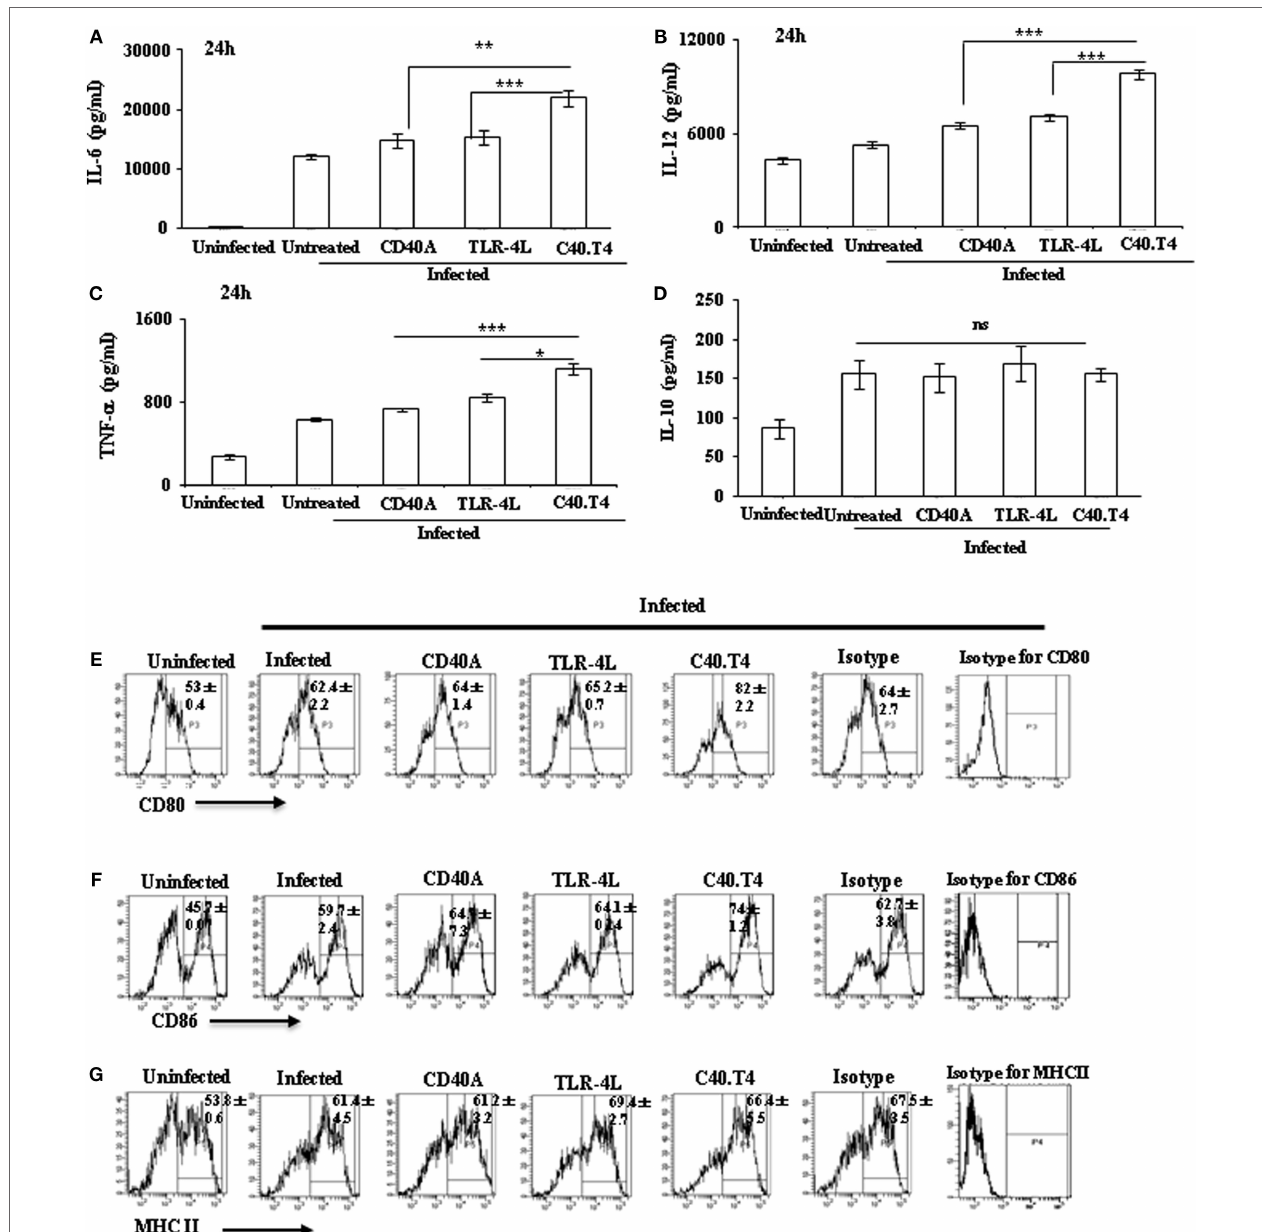
FigUre 1 | signaling through c40.T4 enhanced the production of cytokines and expression of cD80, cD86, and Mhcii on Mtb -infected Dcs . Mtb -infected DCs were stimulated through C40.T4 for 24 h. Control cultures were also set using CD40A, TLR4L, isotype-matched controls, and medium alone. Later, SNs were harvested for the detection of (a) IL-6; (B) IL-12; (c) TNF- α ; (D) IL-10 by ELISA and expressed as pg/ml. Data shown as mean ± SD are normalized with their respective isotype-matched controls. CD11c + DCs were phenotyped by flowcytometry for the expression of (e) CD80 ( p < 0.001); (F) CD86 ( p < 0.01); (g) MHCII. Data expressed as mean ± SD of percent positive cells are representative of three independent experiments. “*,” “**,” and “***” indicate p < 0.05, p < 0.01, and p < 0.001,